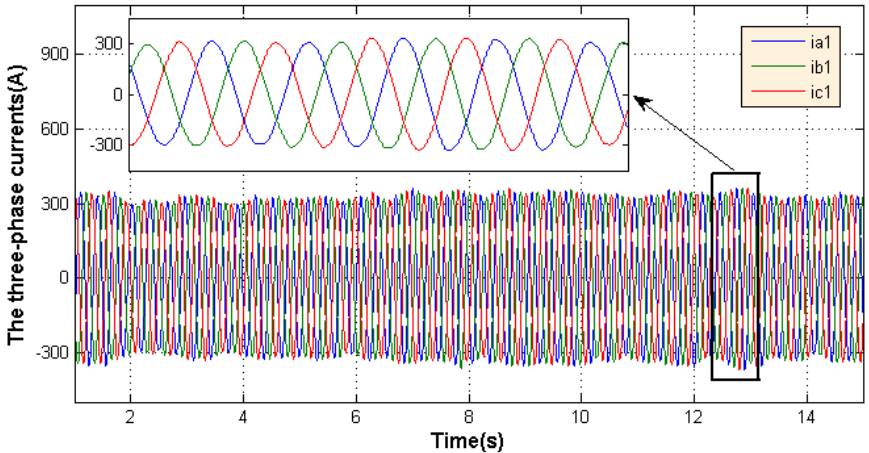
Figure 7. The effectiveness of the active fault-tolerant control on the three-phase currents of faulty